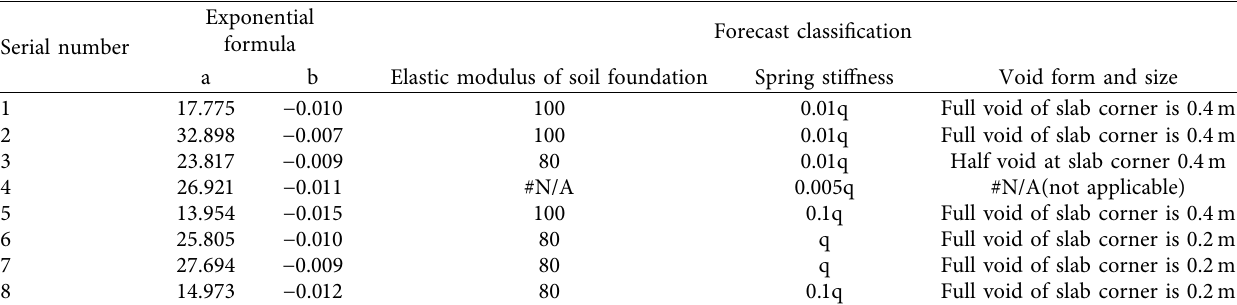
Table 11: Judgment of soil foundation modulus, spring stiffness, and void